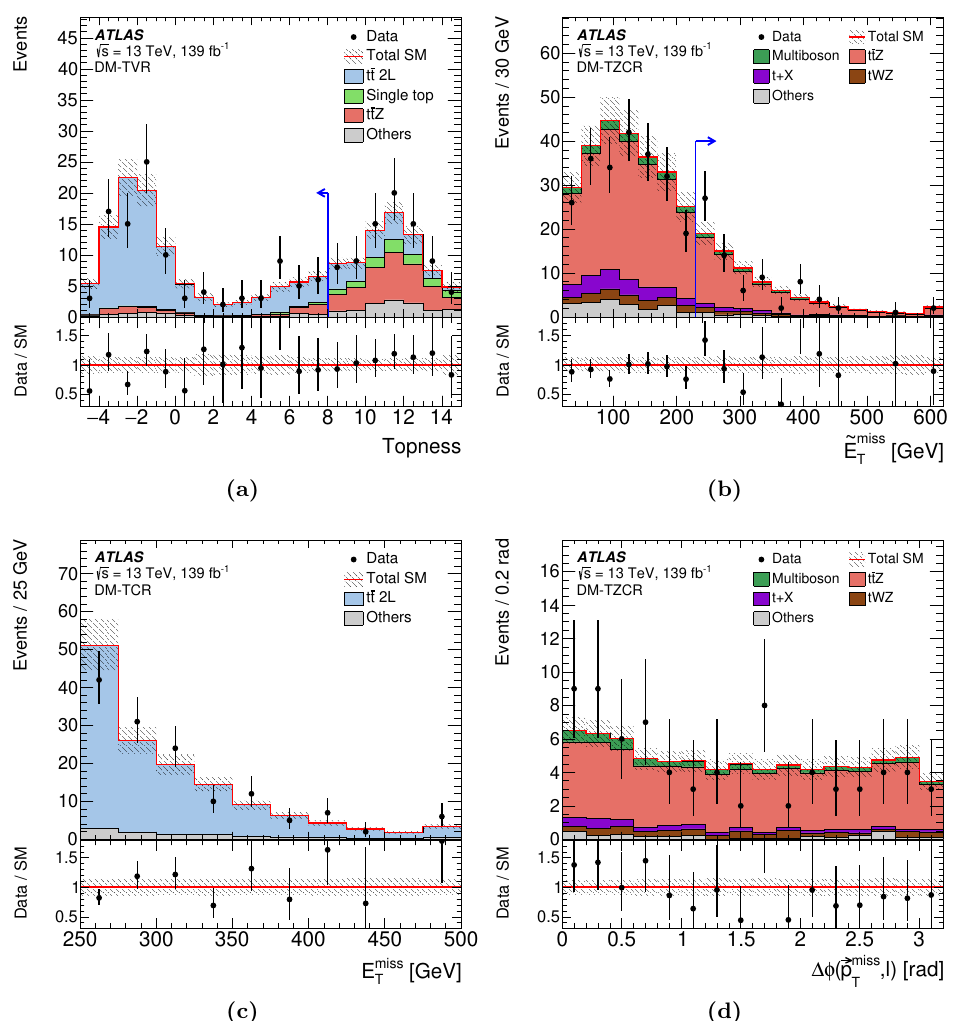
Figure 5. Selected kinematic distributions in DM CRs and VRs: (a) topness in the TVR before applying the topness selection, (b) ˜ E miss in the TZCR before applying the ˜ E miss selection, (c) E miss T T T in the TCR, (d) ∆ φ ( ~p miss , ‘ ) in the TZCR. For distributions where the requirement on the displayed T variable is removed an arrow indicates the final selection on that variable. The distributions shown are post-fit, i.e. each background is scaled by a normalisation factor obtained from a background-only likelihood fit to the CRs (see table 14). The hatched area around the total SM prediction and the hatched band in the Data/SM ratio include all statistical and systematic uncertainties. The last (first) bin contains overflows